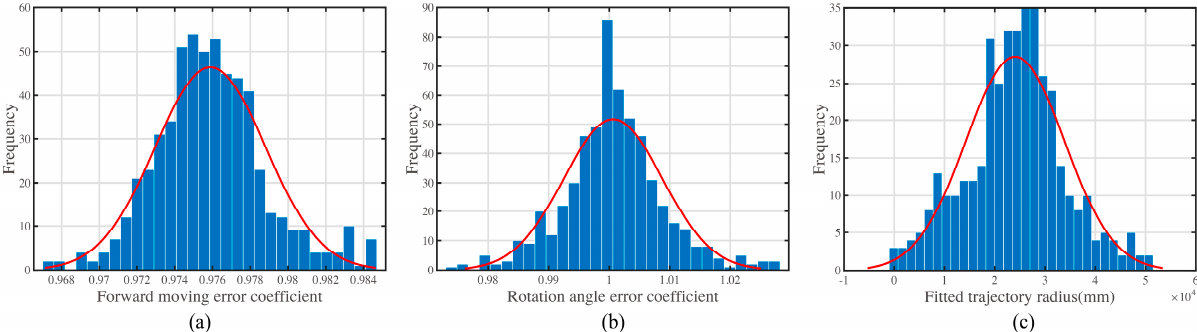
Figure 12. The distribution of the error parameter from experiments. ( a ) The distribution of the forward moving error coefficient. ( b ) The distribution of the rotation angle error coefficient. ( c ) The distribution of the fitted trajectory radius.